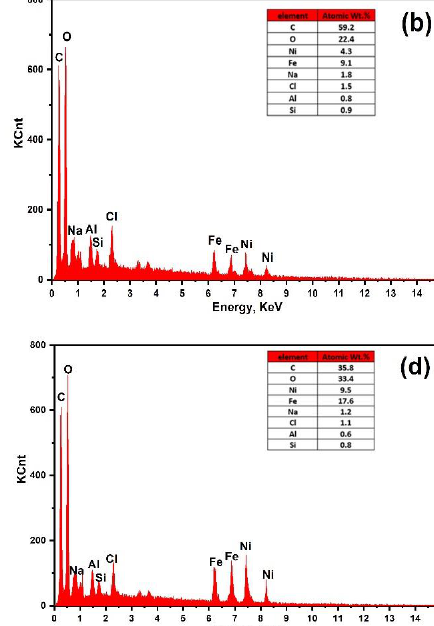
Figure 7. SEM images of ( a ) pure AC, ( b ) 10NFAC, ( c ) 25NFAC, ( d ) 45NFAC, and ( e ) 65 NFAC.